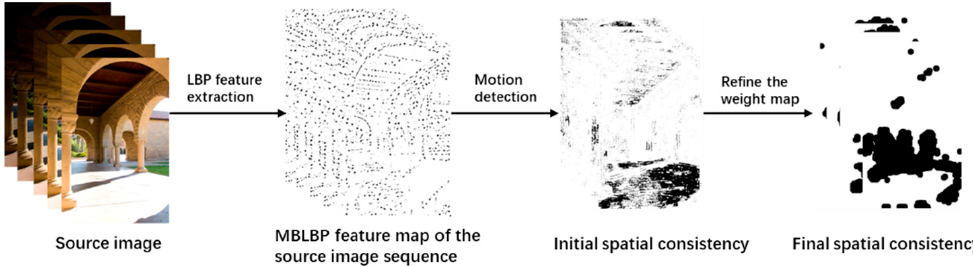
Figure 2. Flow diagram of the motion detection based on the multi-scale LBP.